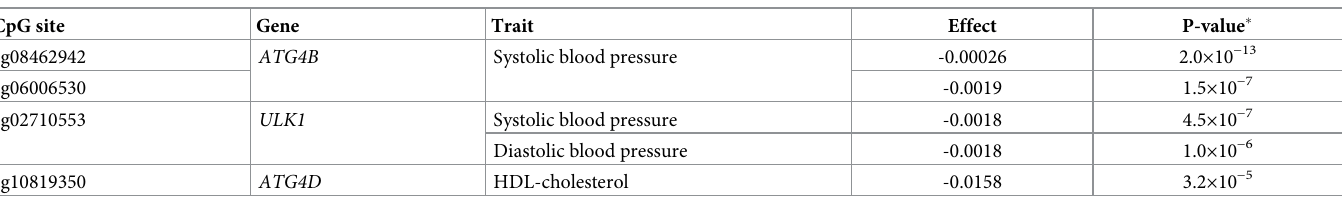
Table 5. DNA methylation, blood pressure and